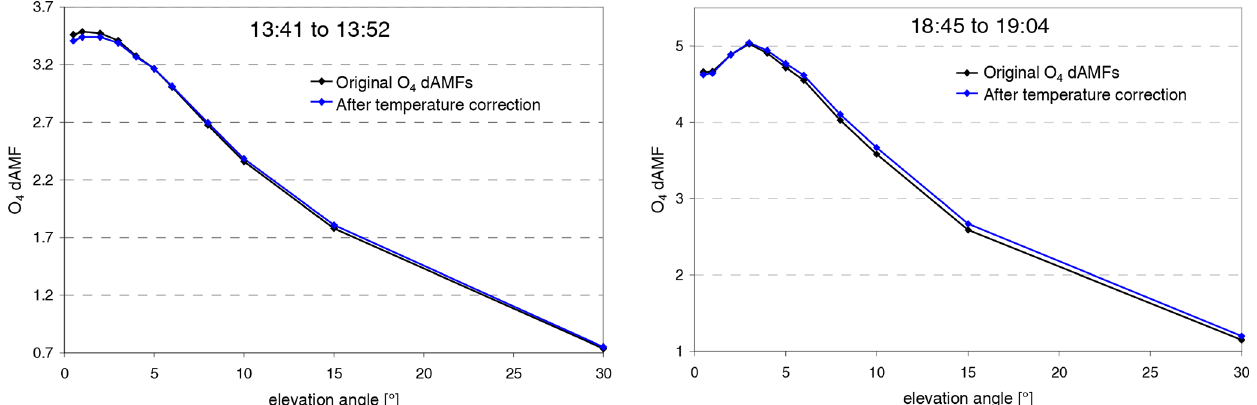
Figure A11. Effect of the temperature correction for two selected elevation